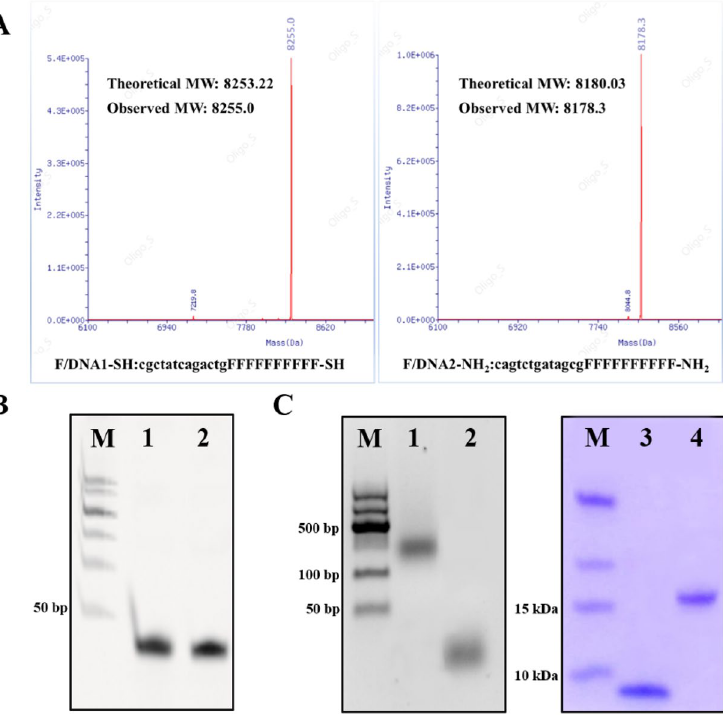
Figure 1. Characterization of F/DNA1-SH, F/DNA2-NH 2 and F/DNA2-affibody. ( A ) Mass spectrometry of F/DNA1-SH, F/DNA2-NH 2 . ( B ) Denaturing PAGE analysis of F/DNA1-SH and F/DNA2-NH 2 . Lane 1, F/ DNA1-SH; Lane 2,